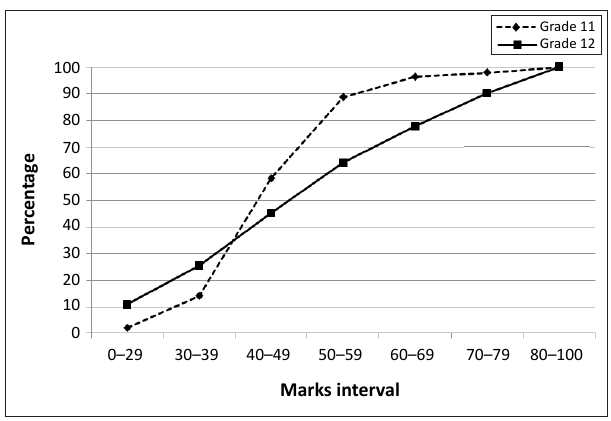
FIGURE 3: Cumulative distribution of Grade 11 and Grade 12 mathematics